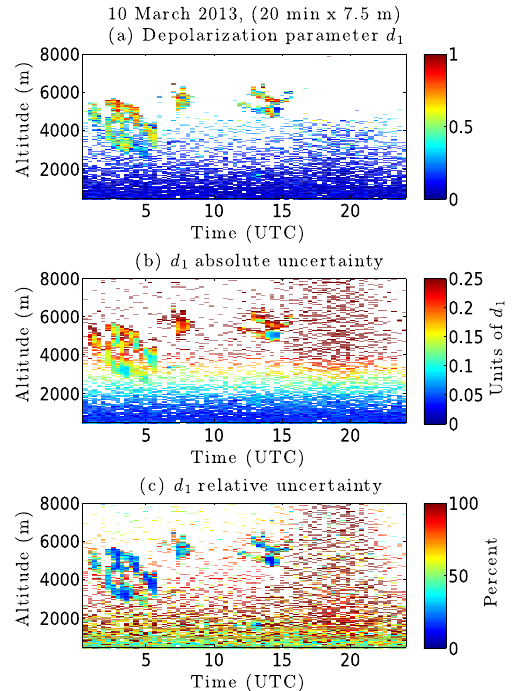
Figure 3. (a) Traditional method d 1 depolarization values from 10 March 2013. (b) Absolute uncertainties associated with the d 1 val- ues, in units of depolarization parameter. (c) Relative uncertainties, in units of percent. Any locations with photocount signal-to-noise ratios less than 1 have been removed and are coloured white. No points have been removed based on calculated uncertainty in d 1